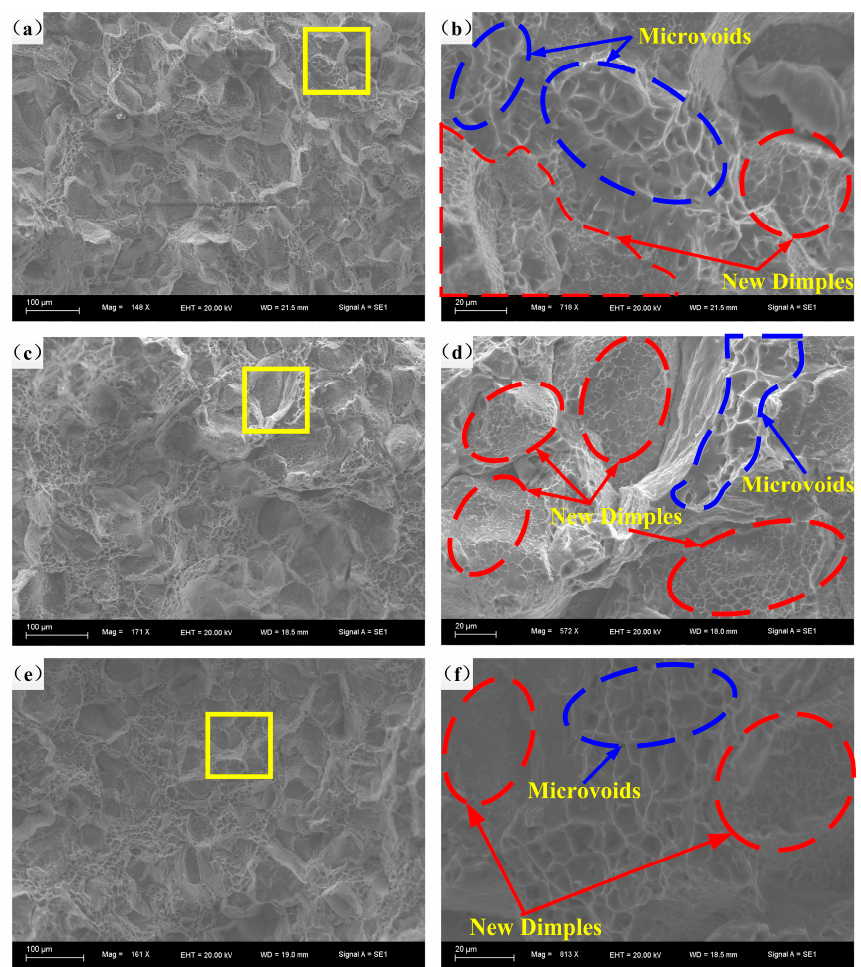
Figure 11. Fracture morphologies at 200 °C and strain rates of: ( a , b ) 10 − 3 s − 1 ; ( c , d ) 10 − 2 s − 1 ; ( e , f ) 10 − 1 s − 1 .